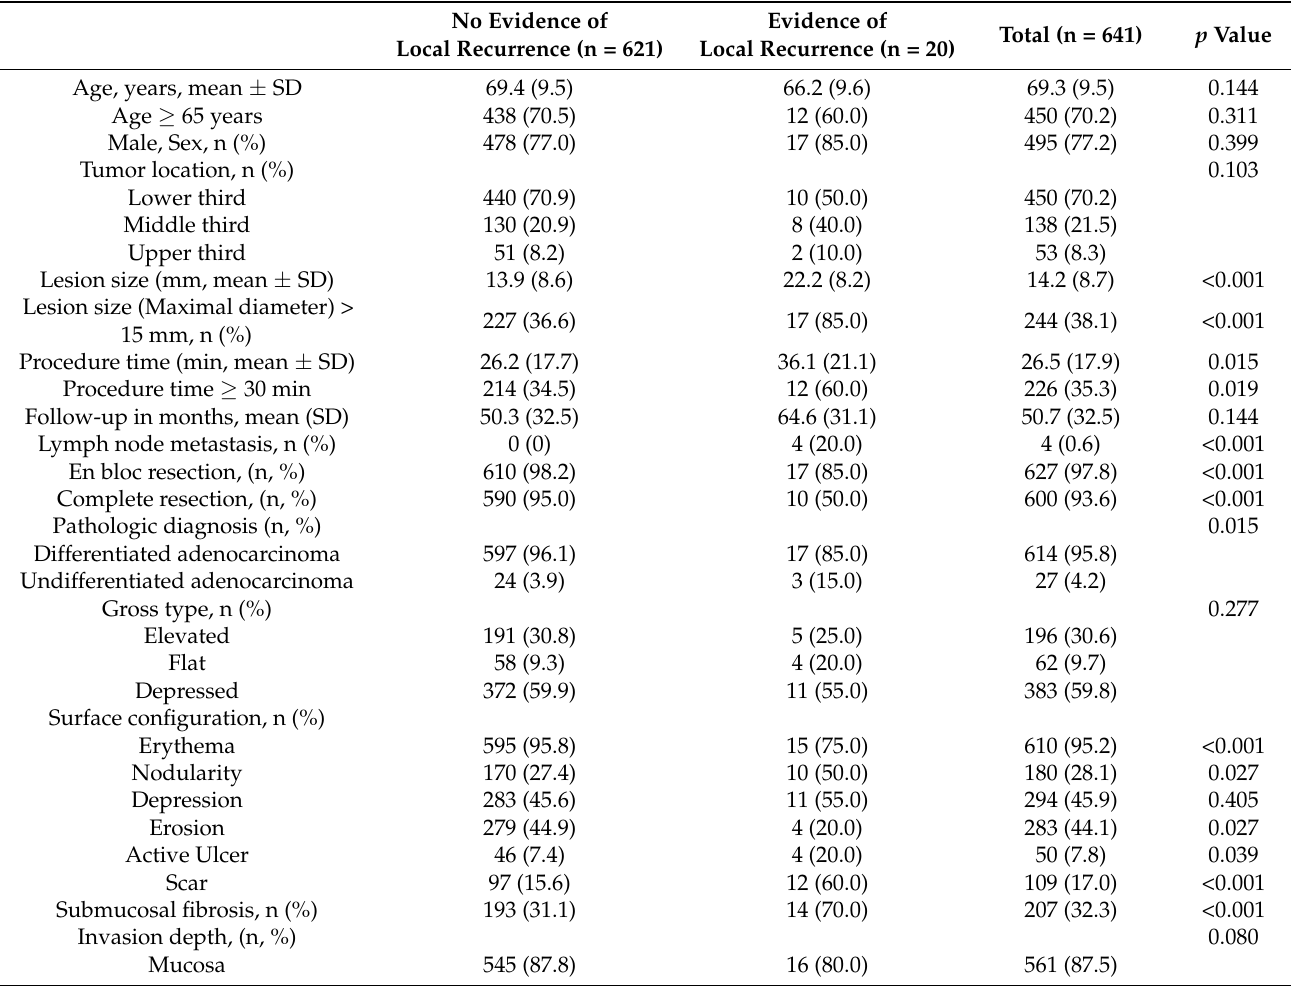
Table 1. Baseline characteristics of early gastric cancer patients at the time of initial ESD and comparison between the presence of local recurrence and the absence of local